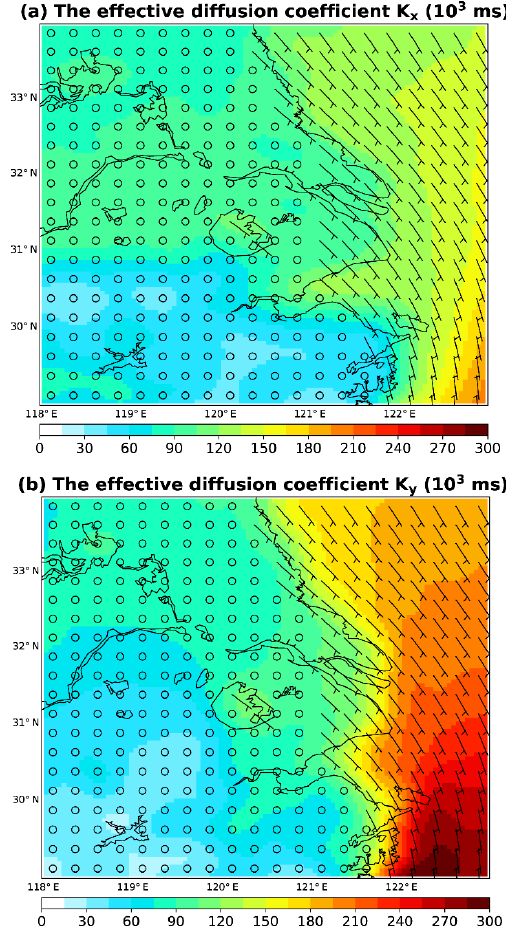
Figure A1. The effective diffusion coefficients for the summer months of 2012–2015 on a 0 . 05 ◦ × 0 . 05 ◦ grid. Overlaid is the tem- poral mean wind vector, which is plotted for every 5 × 5 = 25 grid cells to enhance the